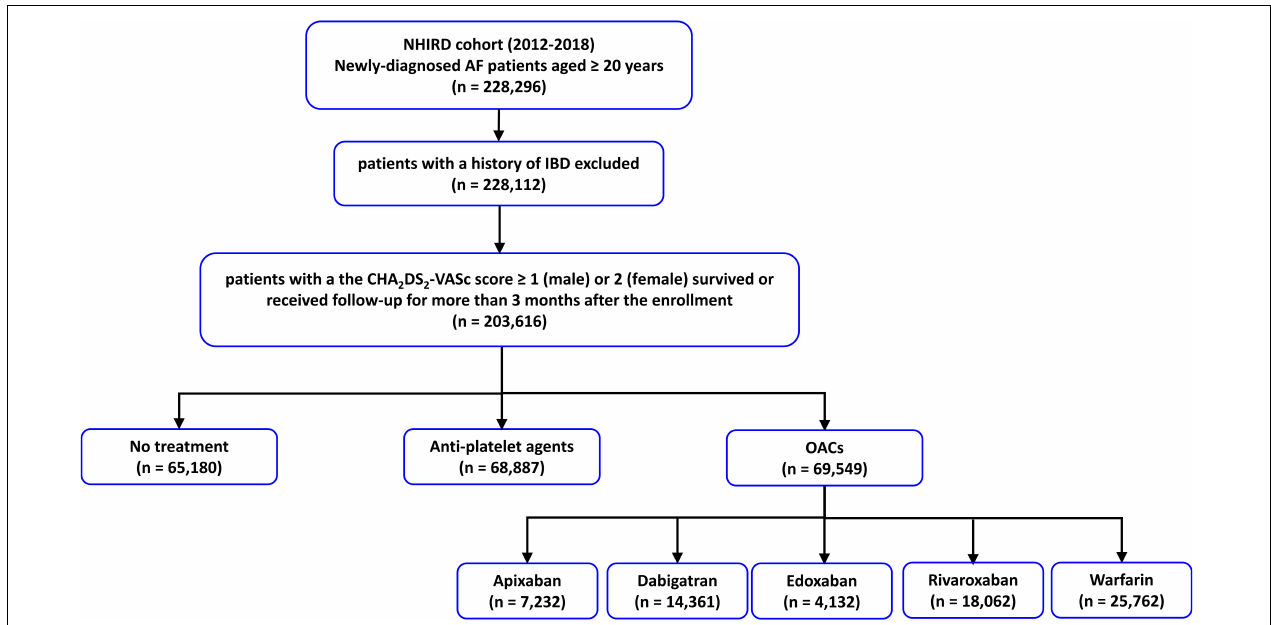
FIGURE 1 | The flowchart of the enrollment of study patients. AF, atrial fibrillation; IBD, ischemic bowel disease; NHIRD, National Health Insurance Research Database; NOACs, non-vitamin K antagonist oral anticoagulants; OACs, oral anticoagulants.